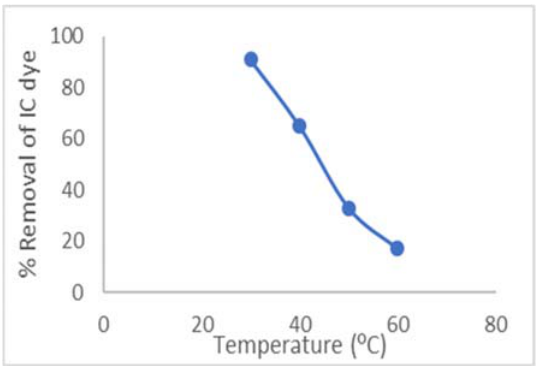
Fig. 10 Effect of temperature on the removal efficiency of IC dye at 30 o C, 4 days contact time, 10 ppm dye concentration and 0.25 gm adsorbent dosage.